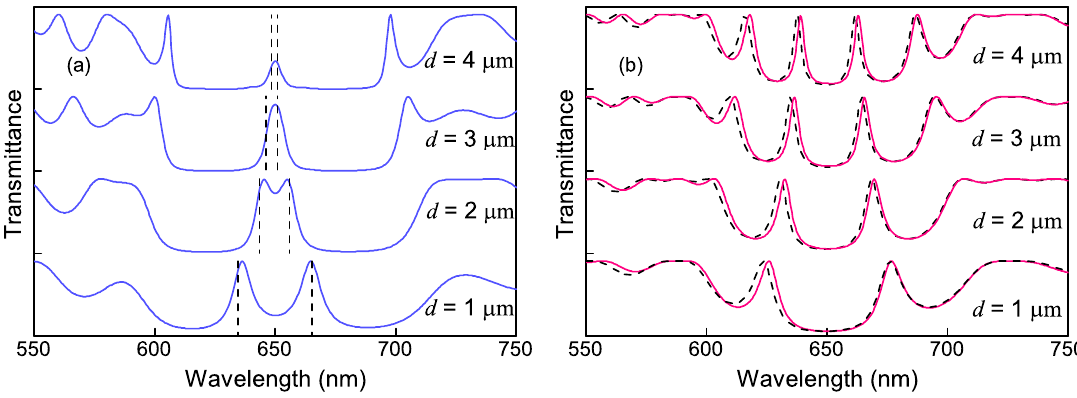
Figure 2. Dependence of the transmittance spectrum for ( a ) the right- and ( b ) left-handed circular polarizations of the incident light on CLC layer thickness d . Dashed lines in Figure 2a show the optical Tamm state (OTS) spectral positions calculated using Formula (9) and dashed lines in Figure 2b the transmittance spectra for the nondiffracting polarization analytically calculated using Formula (11); ϕ = π